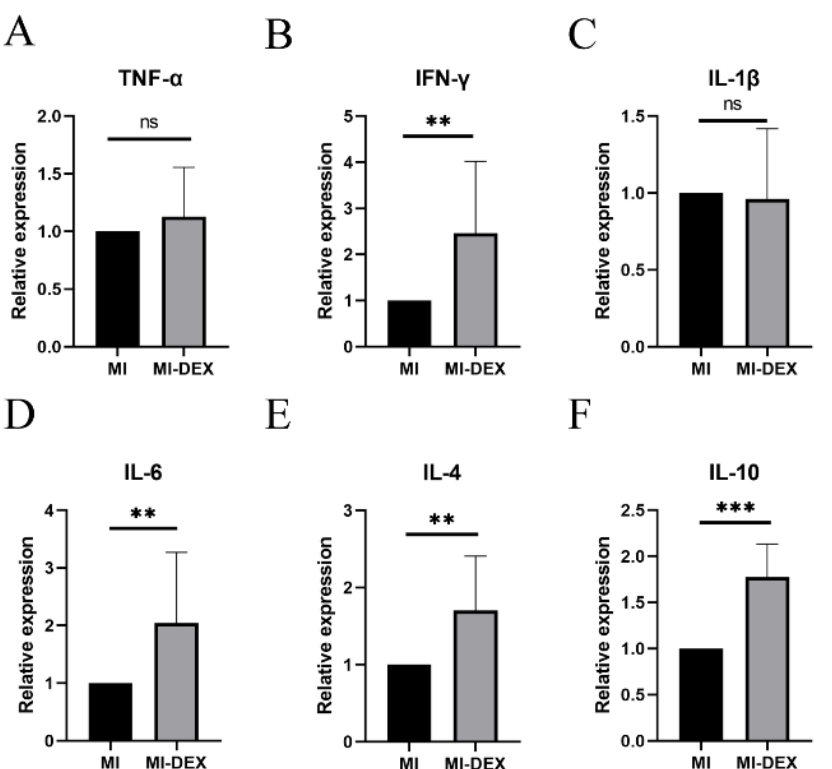
Figure 5. MI-DEXs increase anti-inflammatory cytokine expression in splenic CD4 + T cells. mRNA expression fold changes of different cytokines in different groups (A – F). n = 6 – 12, * p < 0.05, ** p < 0.01, *** p < 0.001; ns, no significance.